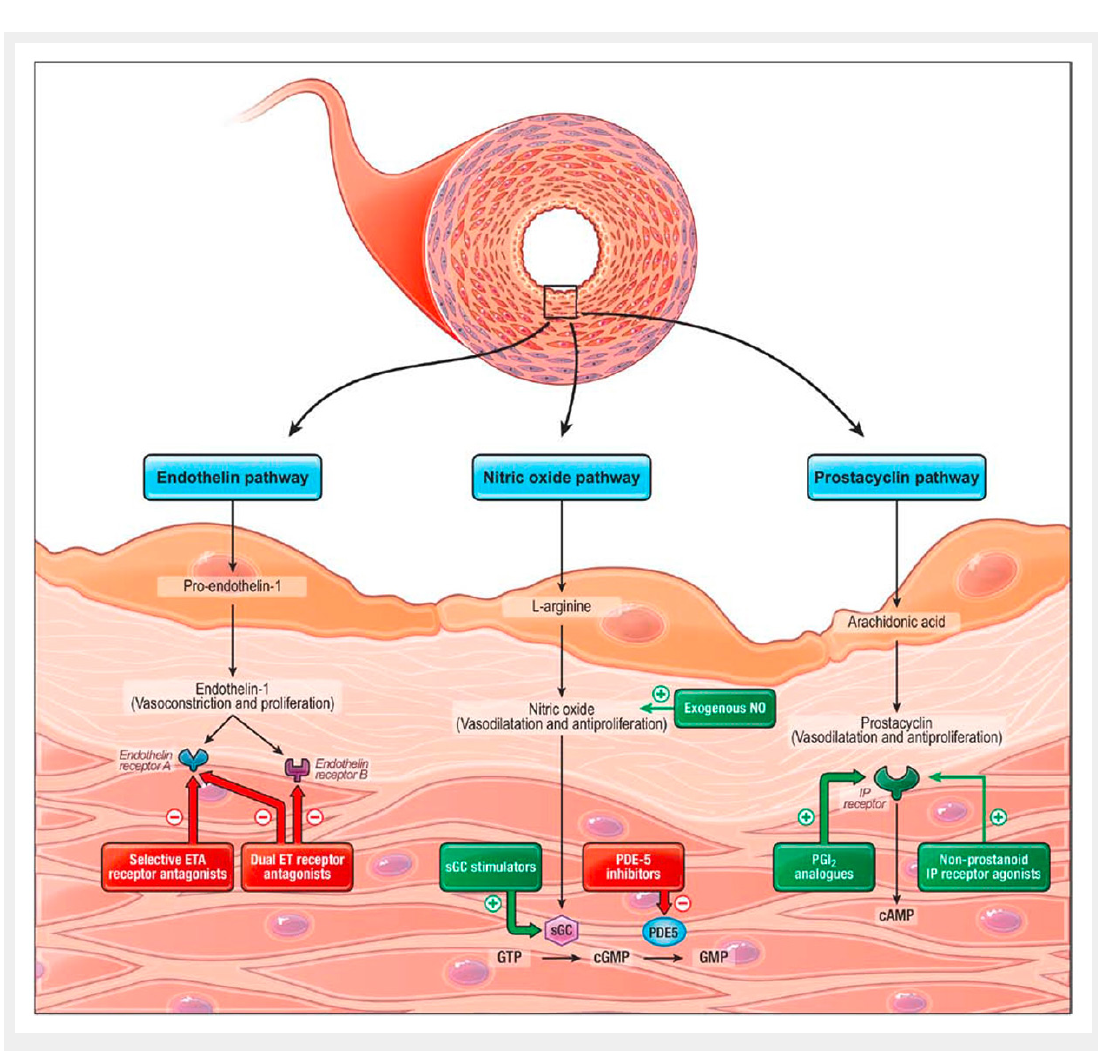
Established pathological pathways modulated by pharmacological substances currently used or in investigation for the treatment of pulmonary arterial hypertension. Antagonists or inhibitors are in red, activators or analogues are in green. (Reproduced with permission from reference [20] Humbert M et al. Advances in therapeutic interventions for patients with pulmonary arterial hypertension. Circulation. 2014;130:2189–208.) cAMP = cyclic adenosine monophosphate; cGMP = cyclic guanosine monophosphate; GTP = guanosine triphosphate; ET = endothelin; ETA = endothelin type A receptor; IP = prostaglandin I2; NO = nitric oxide; PDE-5 = phosphodiesterase type 5; sGC = soluble guanylate